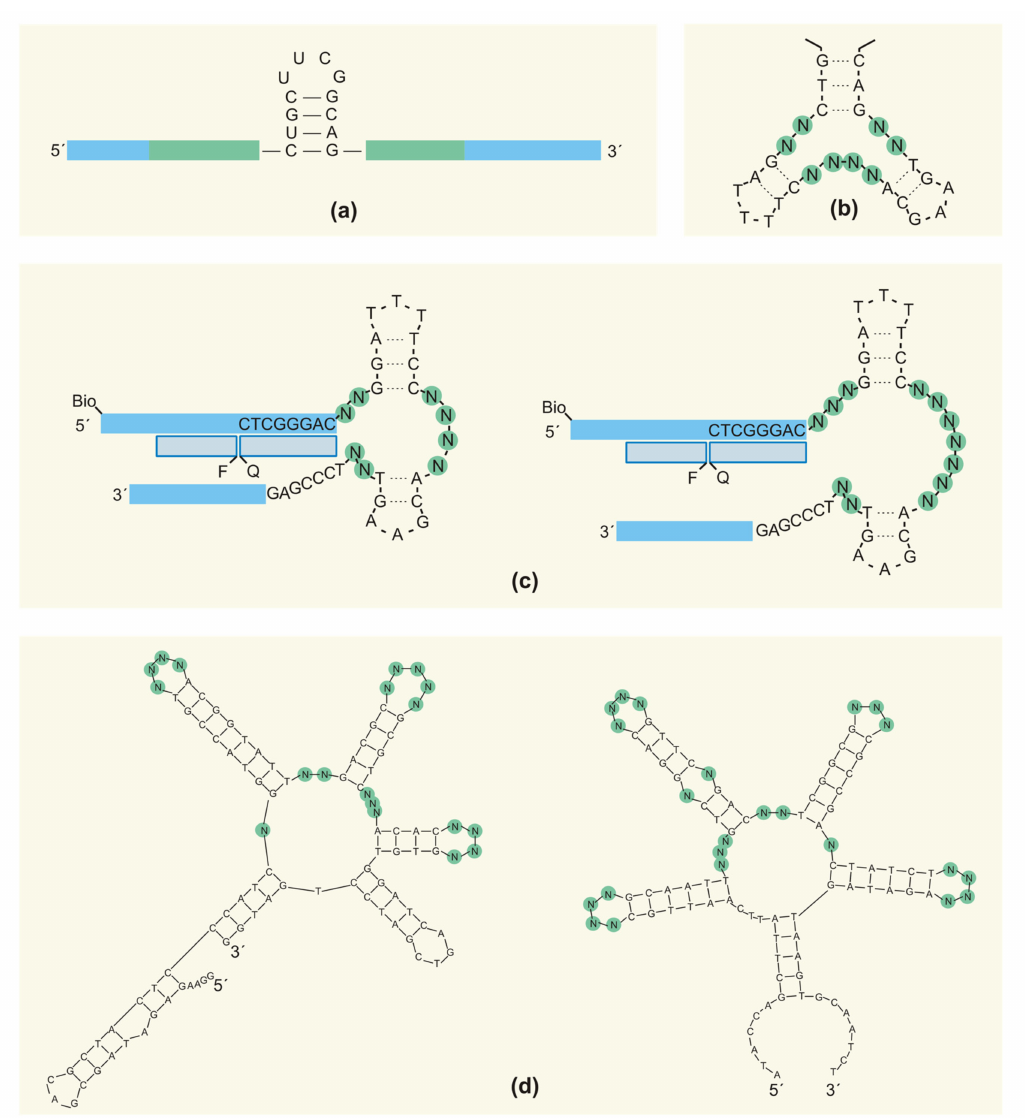
Figure 7. Partially-structured NA libraries. ( a ) The pre-structured RNA library with the stem-loop scaffold engineered in [58]; ( b ) the DNA library with three-way junction scaffolds for a steroid binding engineered in [115]; ( c ) DNA libraries with three-way junction scaffolds for a selection of steroid-binding DNA beacon aptamers [116]; and ( d ) highly structured RNA libraries engineered by the random filtering (left) and genetic filtering (right) approaches